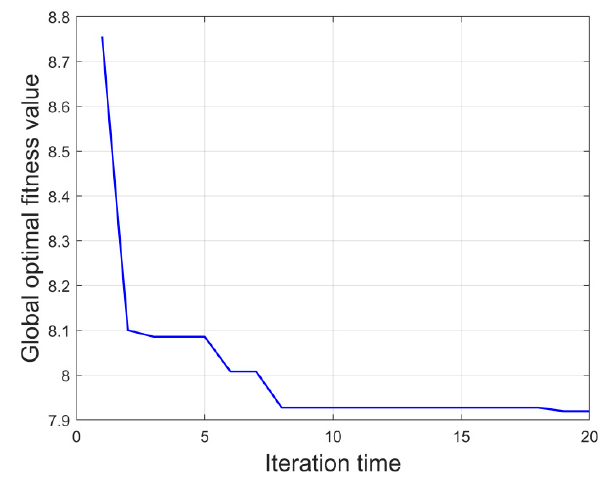
Figure 12. Convergence curve of T-S FLC system.